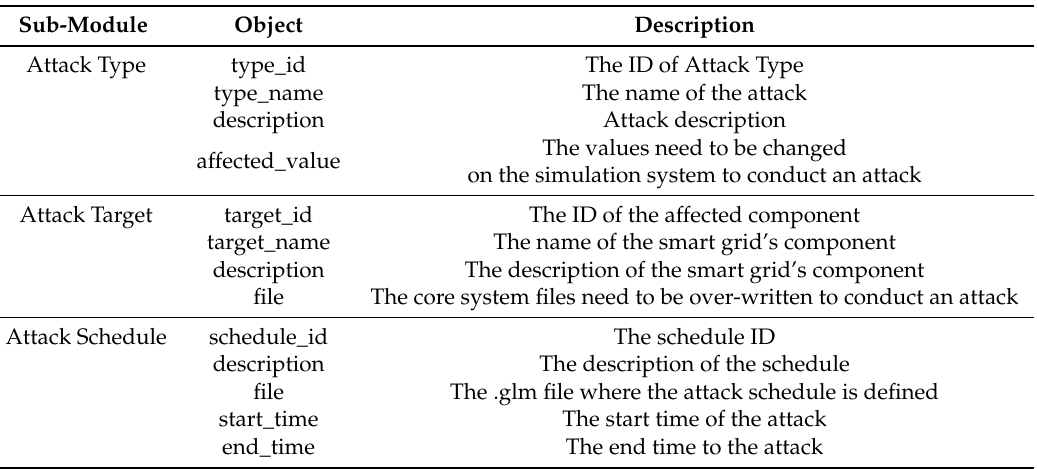
Table 2. Attack pattern library